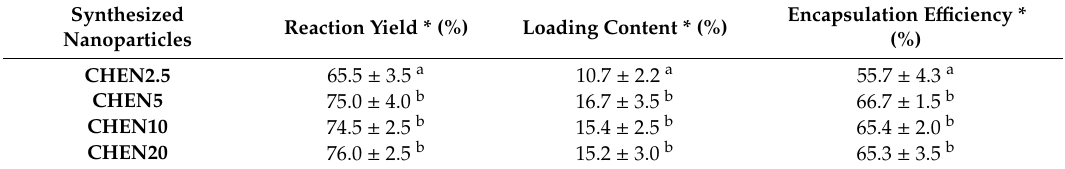
Table 1. Reaction yield, loading content, and encapsulation e ffi ciency of the synthesized nanoparticles. Synthesized Nanoparticles